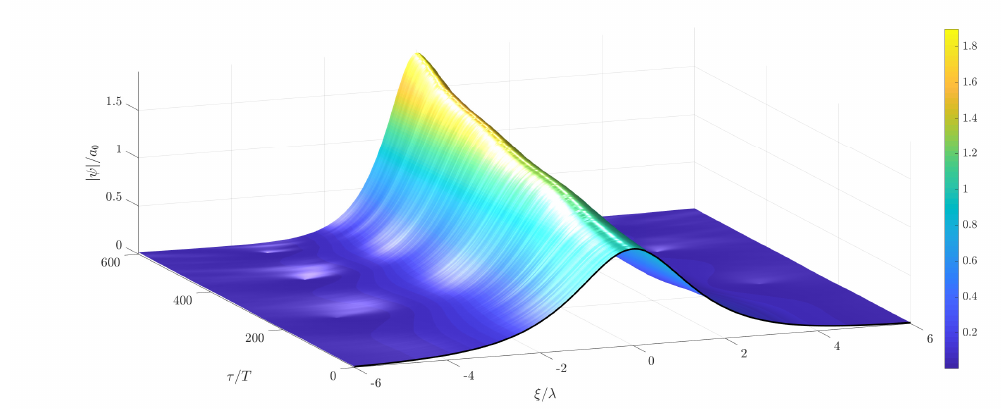
Figure 7. Temporal evolution of a soliton solution of the stochastic NLS with non-white noise excitation in time, mean wind velocity V m = 14 m/s and σ v = 5